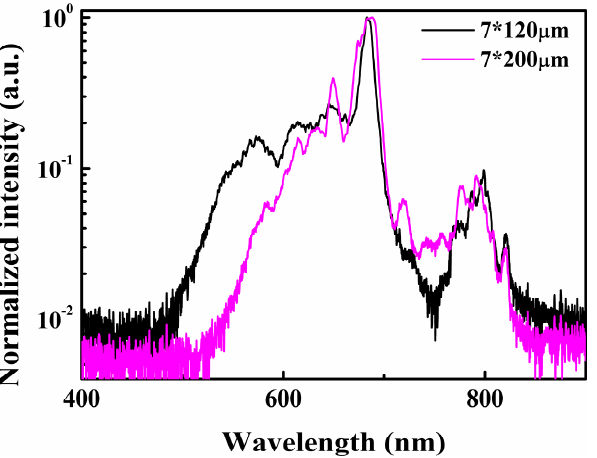
Figure 3. SC spectra after the laser beam propagated through the fused silica thin plates. Each spectrum was normalized by its maximum value.